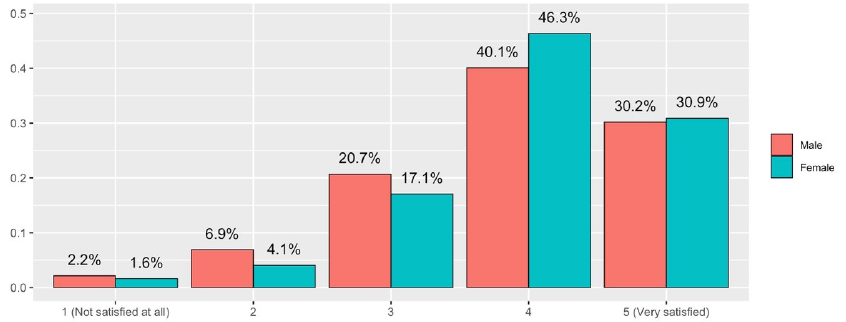
Figure 15. Answers to Q8 disaggregated by gender.